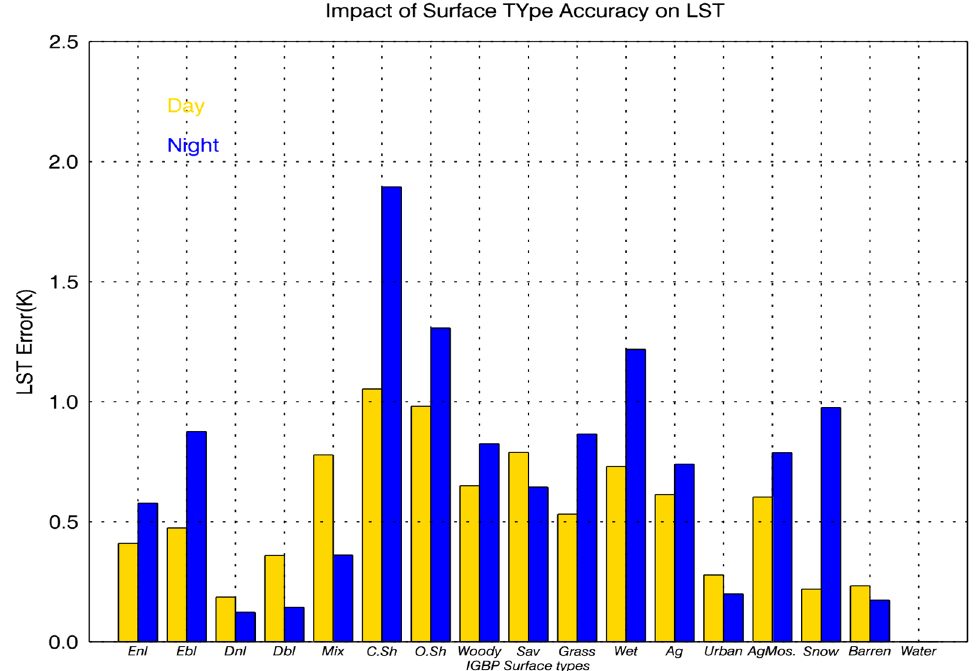
Figure 8. LST uncertainty associated with the uncertainty in surface type classification. These values are estimated using the simulation dataset for all surface types and day/night